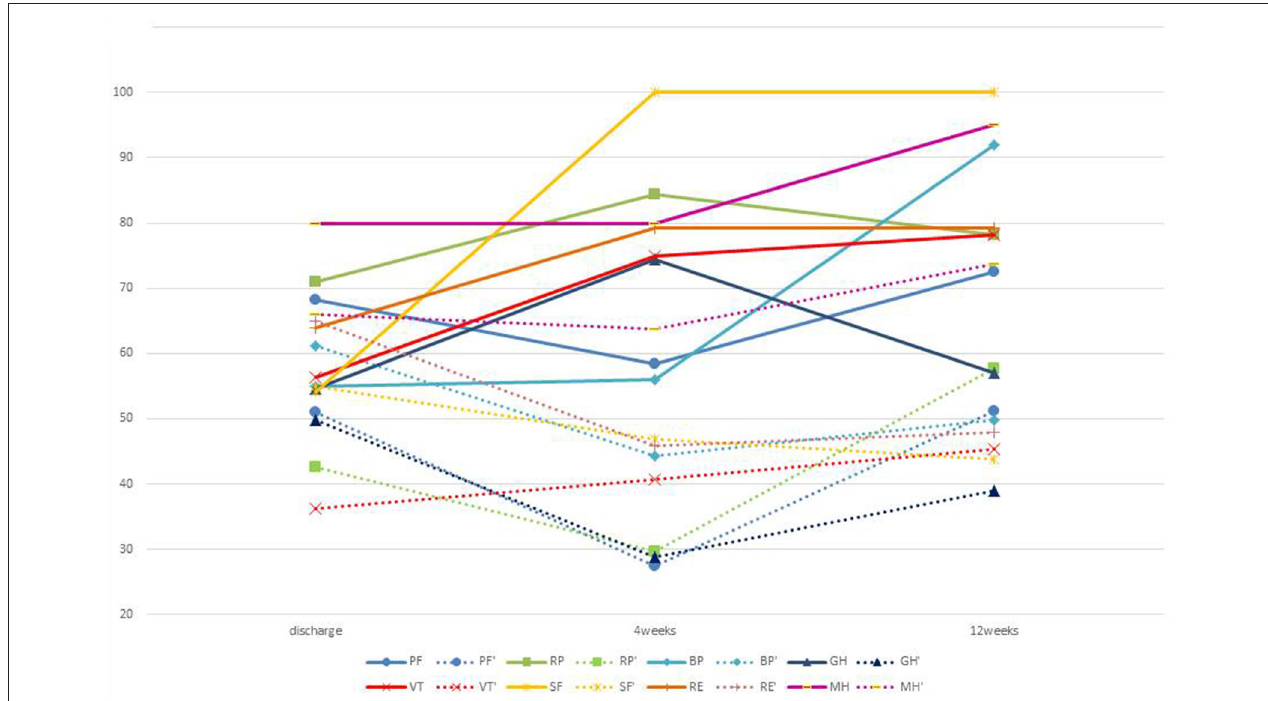
FIGURE 1 | Average transition of SF36 with and without ninjin’yoeito. PF, RP, BP, GH, VT, SF, RE, MH: average value of SF-36 of three people who received ninjin’yoeito. RF’, RP’, BP’, GH’, VT’, SF’, RE’, and MH’: average value of SF-36 of five people who did not receive